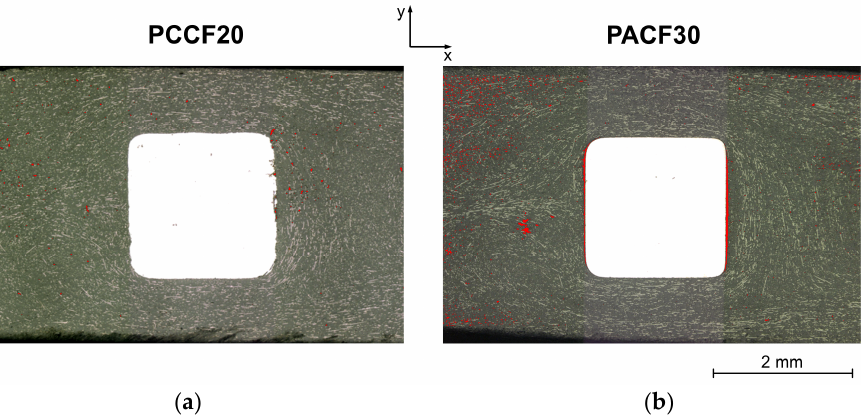
Figure 16. Microscopic images with marked air pockets and voids (red) of the pin areas of the specimen PC CF20_5 mm ( a ) and PA CF30_5 mm ( b ).